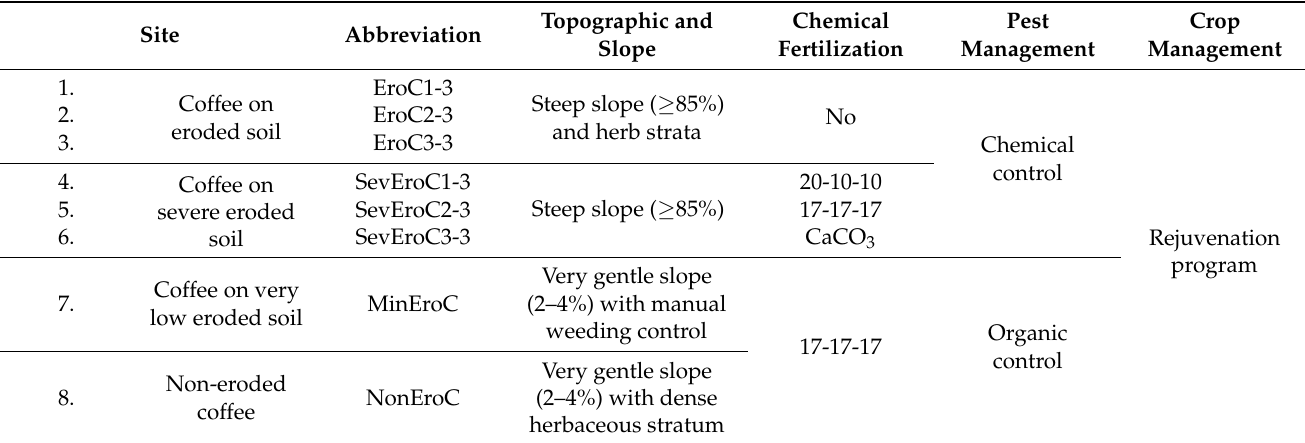
Table 2. Principal agricultural management practices and standing crops at the sampling data for field